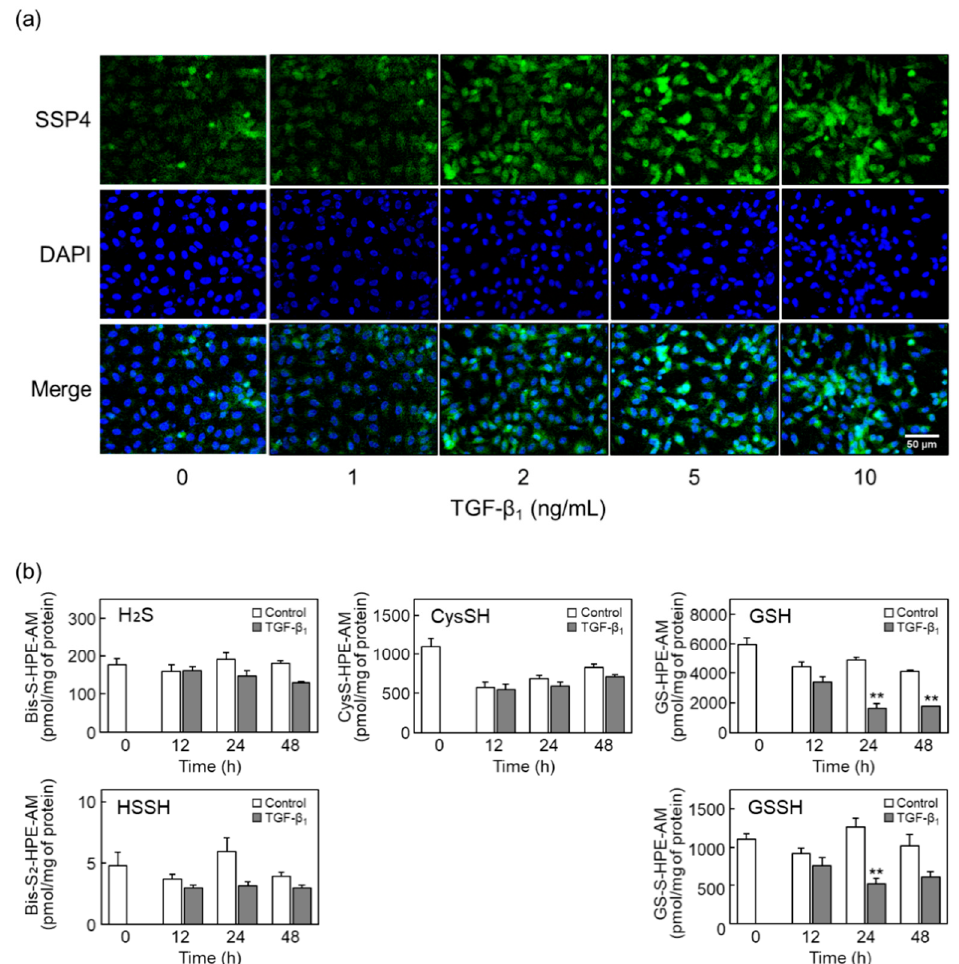
Figure 1. Effects of TGF- β 1 on intracellular RSS levels in vascular endothelial cells. ( a ) Fluorescence imaging of sulfane sulfur in vascular endothelial cells treated with TGF- β 1 . Confluent cultures of vascular endothelial cells were treated with TGF- β 1 (1, 2, 5, or 10 ng/mL) for 24 h and were then stained with SSP4 (for sulfane sulfur, green) and DAPI (for nuclei, blue). Scale bar = 50 µm. The data are representative of two independent experiments. ( b ) Quantification of low-molecular-mass RSS and the corresponding substrates in vascular endothelial cells treated with TGF- β 1 . Confluent cultures of vascular endothelial cells were treated with TGF- β 1 (10 ng/mL) for 12, 24, or 48 h, and the concentration of each molecule was measured using LC-ESI-MS/MS. Values are the mean ± standard error (S.E.) of three independent samples. Data were analyzed using Student’s t -test. ** Significantly different from the corresponding control, p < 0.01.